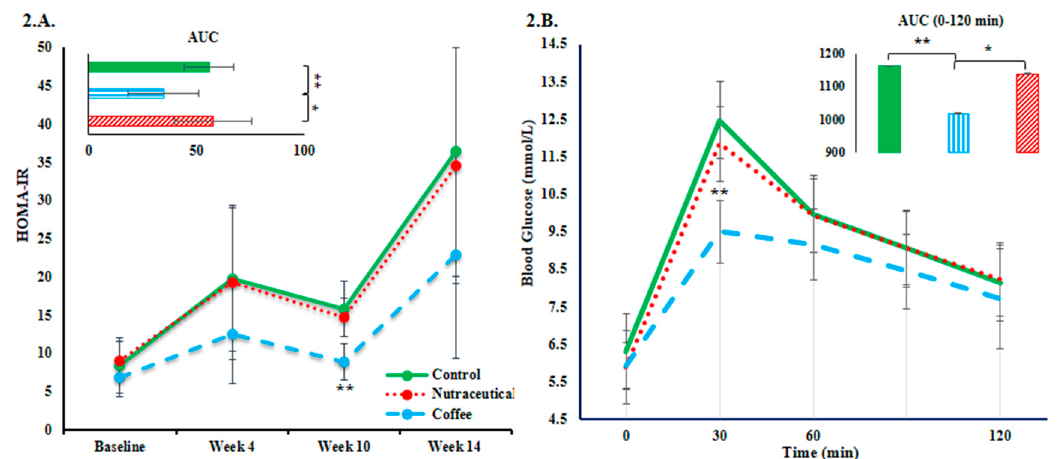
Figure 2. Surrogate measures of insulin resistance: ( A ) changes in HOMA-IR in each study group and its area under the curve (AUC); ( B ) repeated plasma glucose measurements during an oral glucose tolerance test and the AUC of changes in the first two hours. Error bars are standard deviation of the mean. Asterisks denote significantly different values (* p < 0.05, ** p < 0.01).